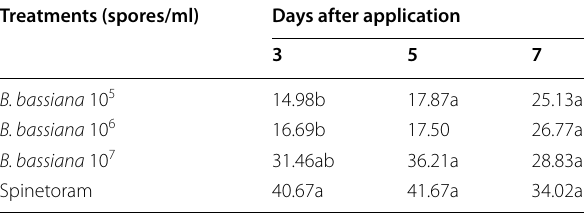
Values with the same lowercase letters were not significantly difference according to Tukey’ test, α